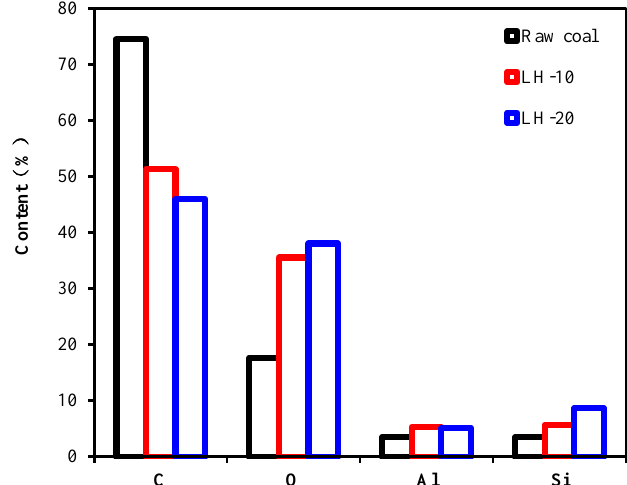
Figure 5. Chemical compositions before and after heating oxidation at 200 °C from EDS plane sweep.